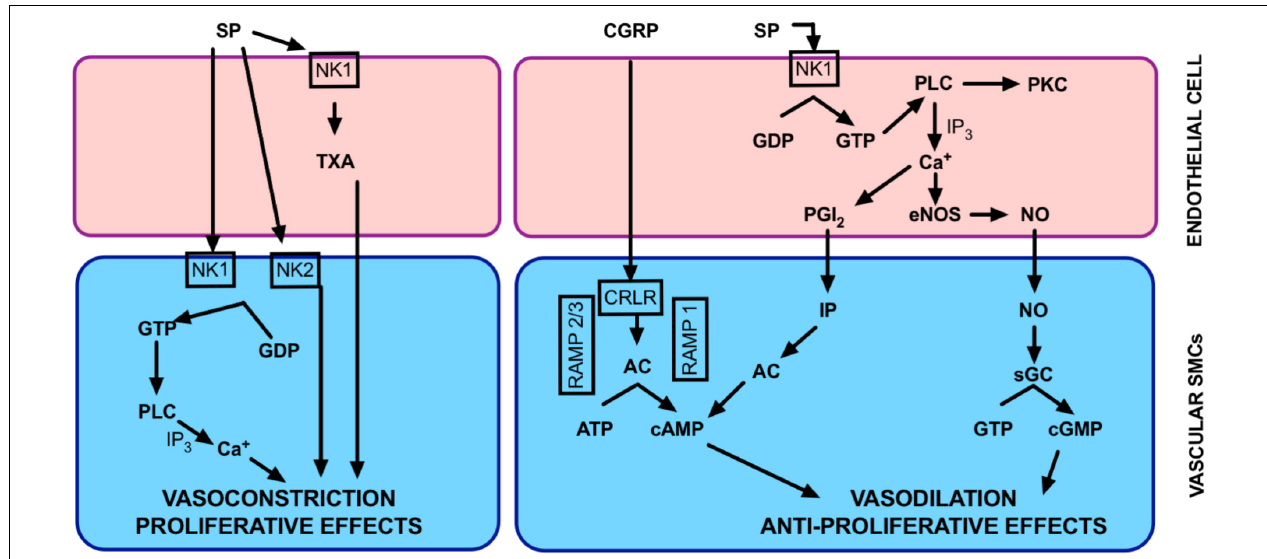
FIGURE 4 | Overview of neuropeptide function in the lung circulation. Proposed mechanisms by which CGRP and Substance P may be effective in regulating pulmonary vascular tone. AC, adenylate cyclase; cAMP, cyclic adenosine monophosphate; cGMP, cyclic guanosine monophosphate; CRLR, calcitonin receptor-like receptor; eNOS, endothelial nitric oxide synthase; GDP, guanosine diphosphate; GTP, guanosine triphosphate; IP 3 , inositol triphosphate; MAPK, mitogen activated protein kinase; NK, neurokinin; NO nitric oxide; PGI 2 , prostacyclin; PKC, protein kinase C, PLC, phospholipase C; RAMP-1, receptor activity-modifying protein-1; sGC, soluble guanylate cyclase; TXA, thromboxane.